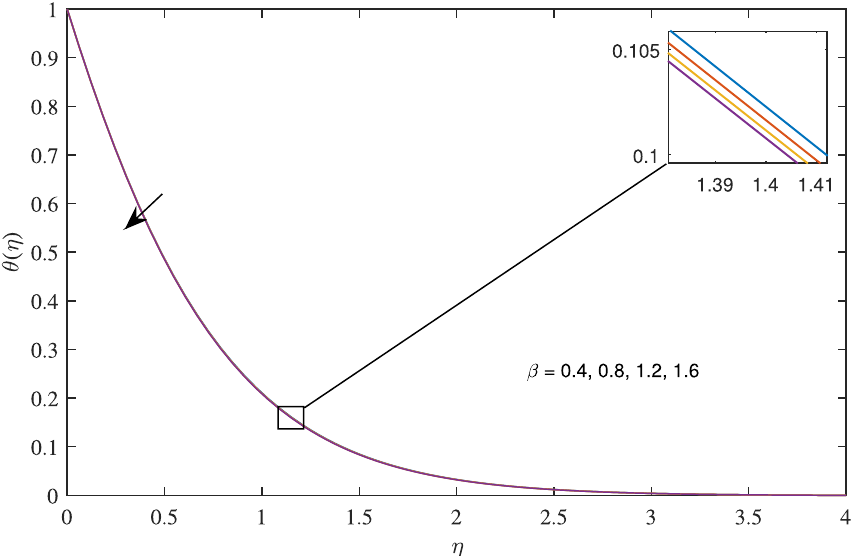
1 , h 0.5 , ζ 0.1 , N 0.2 , rd = = = =